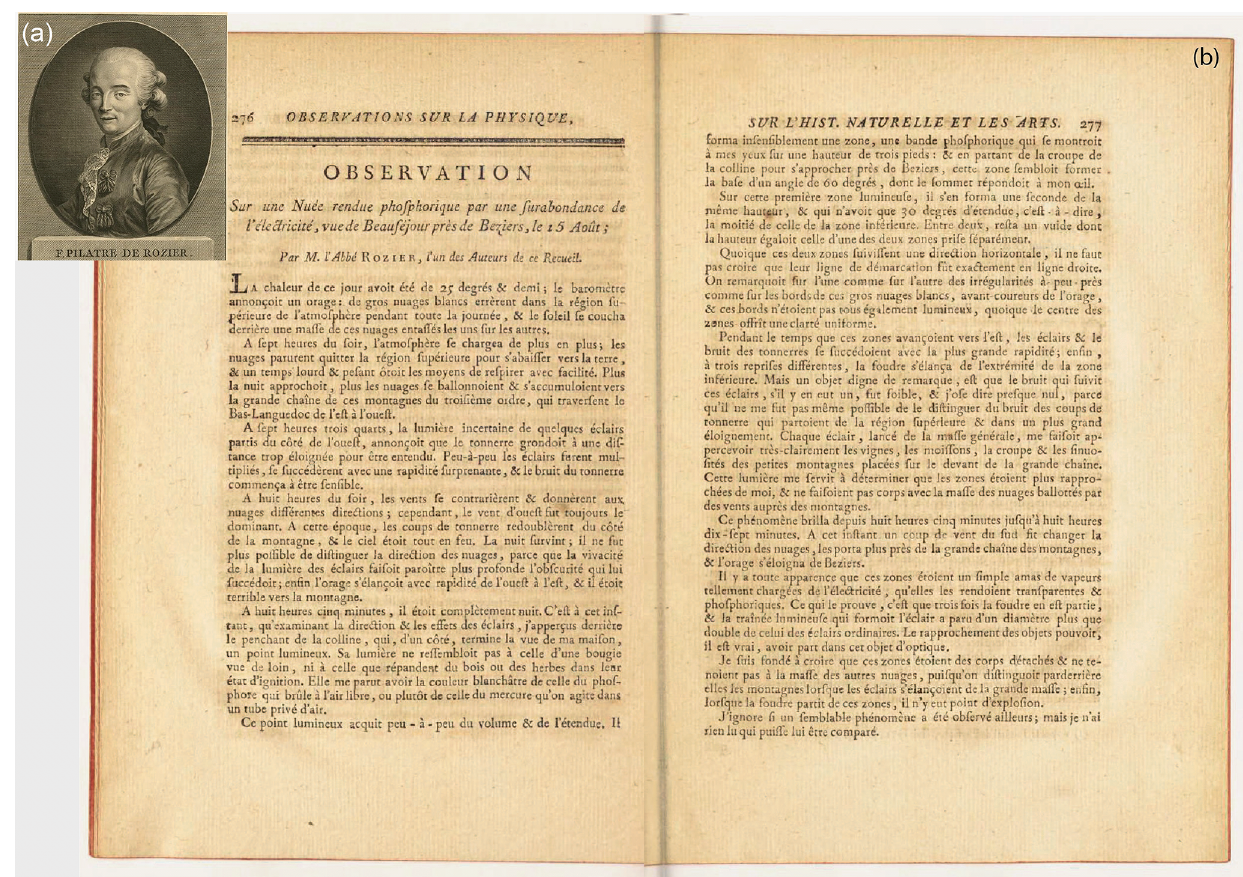
Figure 1. (a) Photographic portrait of abbot François Rozier (photo in the public domain). (b) The two printed pages reporting the aurora observation made by abbot François Rozier on 15 August 1780 in Béziers, France (Rozier,